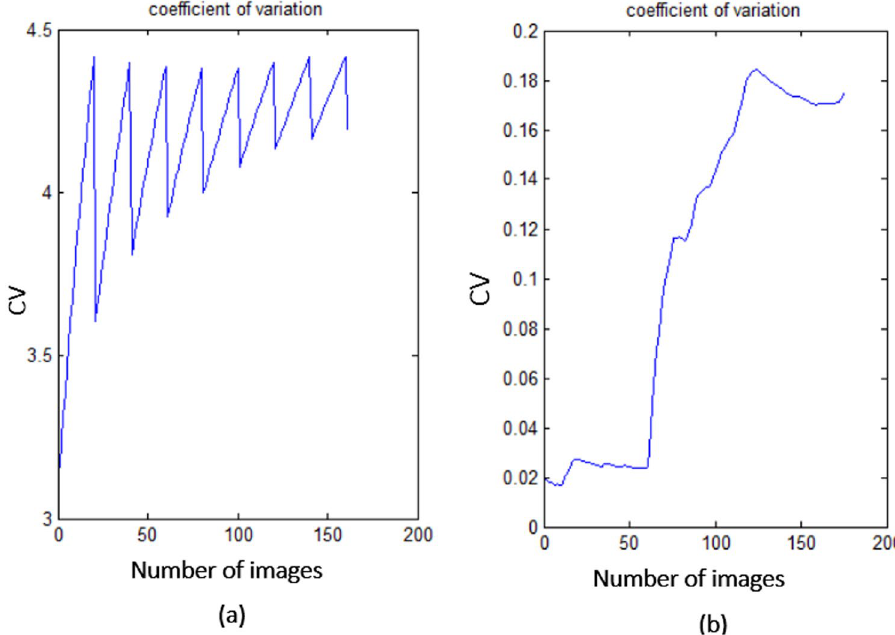
Figure 15. CV plots obtained using static and sliding window respectively.